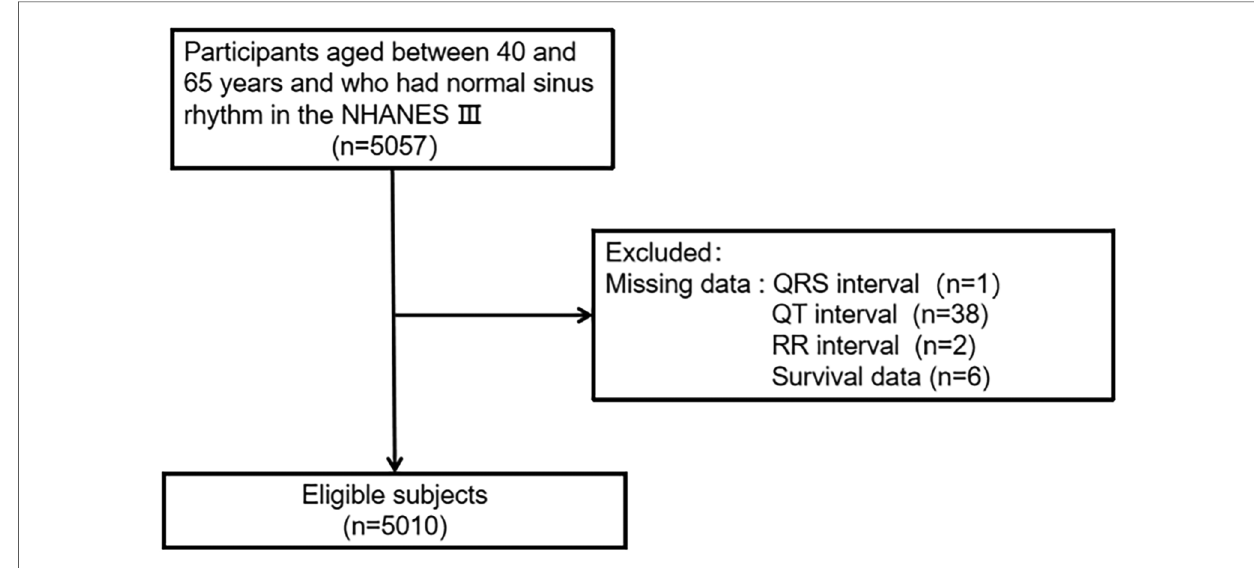
FIGURE 1 The fl ow chart of study case